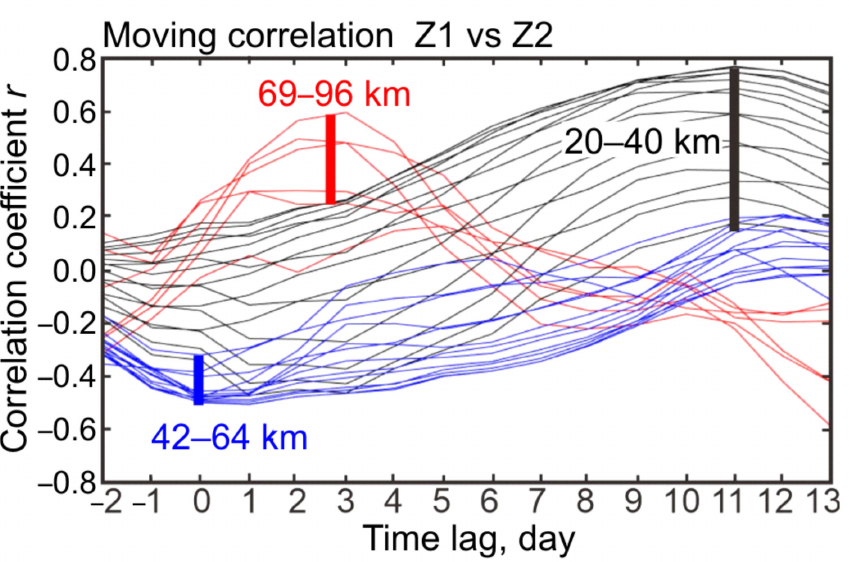
Figure 5. Family of moving correlation curves with time lags of the wave 1 amplitude (Z1) relative to the wave 2 amplitude from –2 days to +13 days. The MLS pressure levels between 60 hPa and 0.001 hPa (20–96 km, totally 34 levels) are presented. Three altitude intervals are shown with colored curves: 20–40 km (lower–middle stratosphere, black curves), 42–64 km (upper stratosphere– stratopause–lower mesosphere region, blue curves), and 69–96 km (upper mesosphere–mesopause region, red curves). Vertical lines indicate the strongest correlations at each altitude interval.